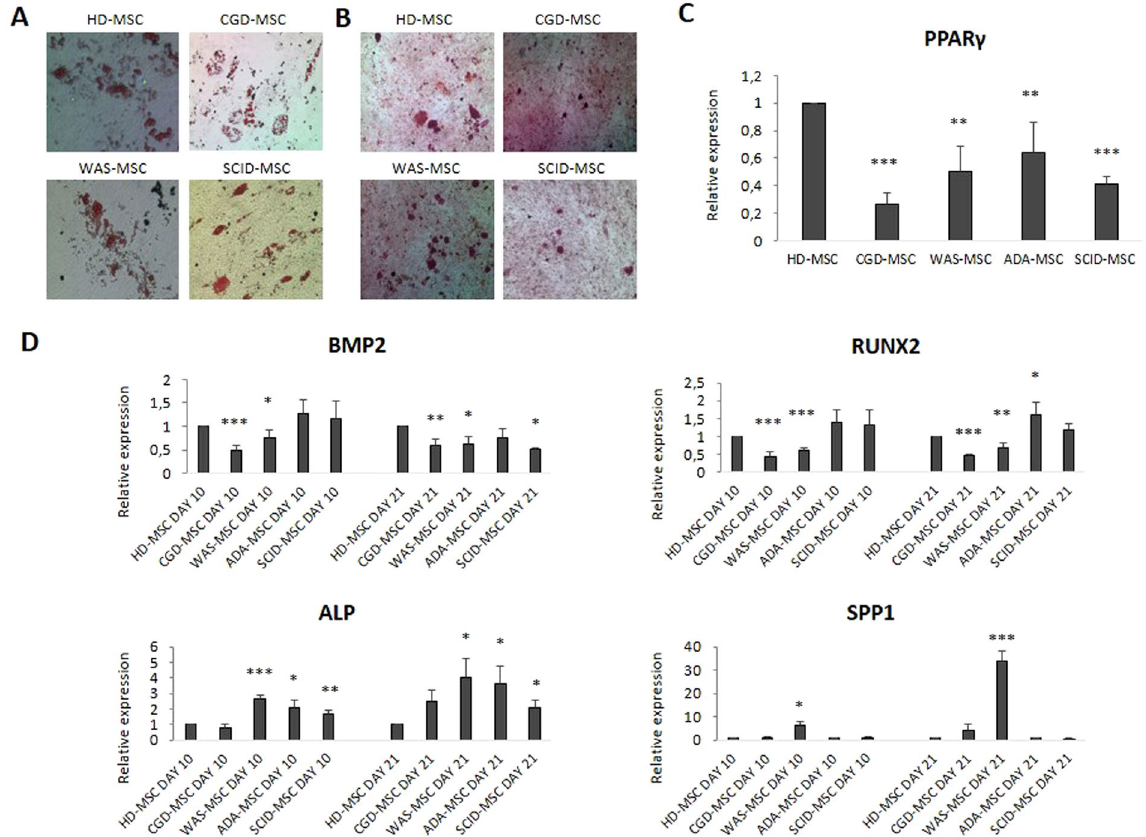
Figure 6. Multi-lineage differentiation potential of HD- and PID-MSCs after 10- and 21-day culture in adipogenic and osteogenic medium. In ( A ) the differentiation into adipocytes is shown by the formation of lipid droplets stained with Oil Red O, magnification x20; in ( B ) the differentiation into osteoblasts is demonstrated by the histological detection of calcium depositions positive for Alizarin Red, magnification x20. ( C , D ) Gene expression of key adipogenic marker PPAR γ (C) and key osteogenic markers BMP2 (early), RUNX2 (early), ALPL (late) and SPP1 (late) (D) on HD- and PID-MSCs after culture in differentiation medium. mRNA levels of the adipogenic marker were quantified on day + 21 of the culture, whereas mRNA levels of osteogenic markers were quantified both on day + 10 and on day + 21 of the culture to reveal the expression of both early and late osteogenic genes by the 2 −ΔΔ Ct method after normalization with respect to GAPDH. Results are expressed as fold-change relative to HD-MSCs. Each bar represents the mean ± SEM of multiple experiments (each point was performed in duplicate and repeated independently at least 3 times for 7 HD-MSC, 5 CGD-MSC, 6 WAS- MSC, 5 ADA-MSC and 5 SCID-MSC sample). P values lower than 0.05 were considered to be statistically significant (compared with HD-MSCs: * p < 0.05; ** p < 0.01; *** p <